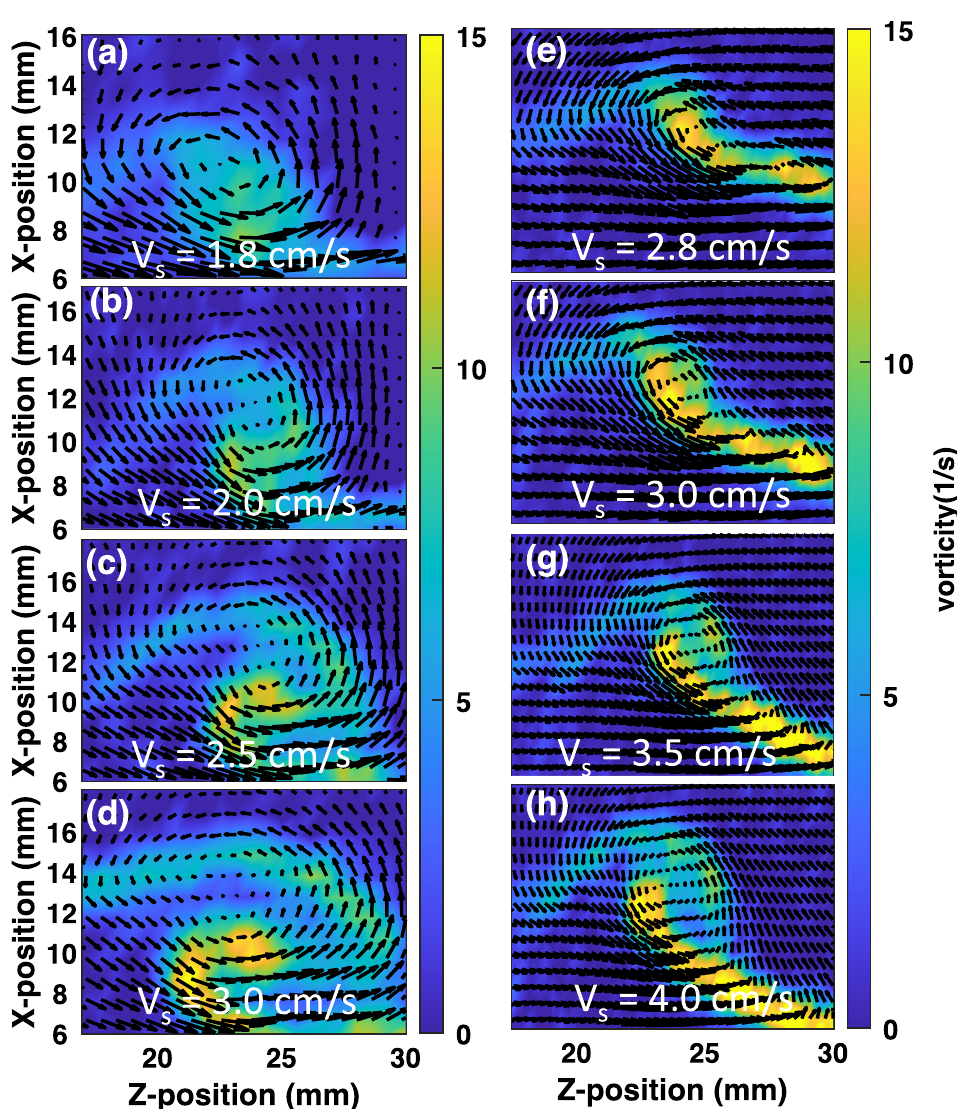
Figure 10. The velocity vectors around the vortex structure and the color map represent the magnitude of vorticity (1/s) for the single-layer flow of shear velocities of ( a ) 1.8 cm/s, ( b ) 2.0 cm/s, ( c ) 2.5 cm/s, ( d ) 3.0 cm/s and double-layer flow of shear velocities of ( e ) 2.8 cm/s, ( f ) 3.0 cm/s, ( g ) 3.5 cm/s and ( h ) 4.0 cm/s, which are obtained from the